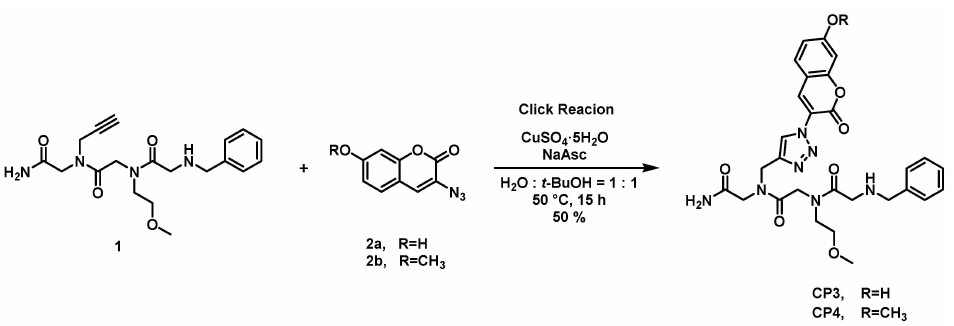
Figure 1. Synthesis of coumarin-attached